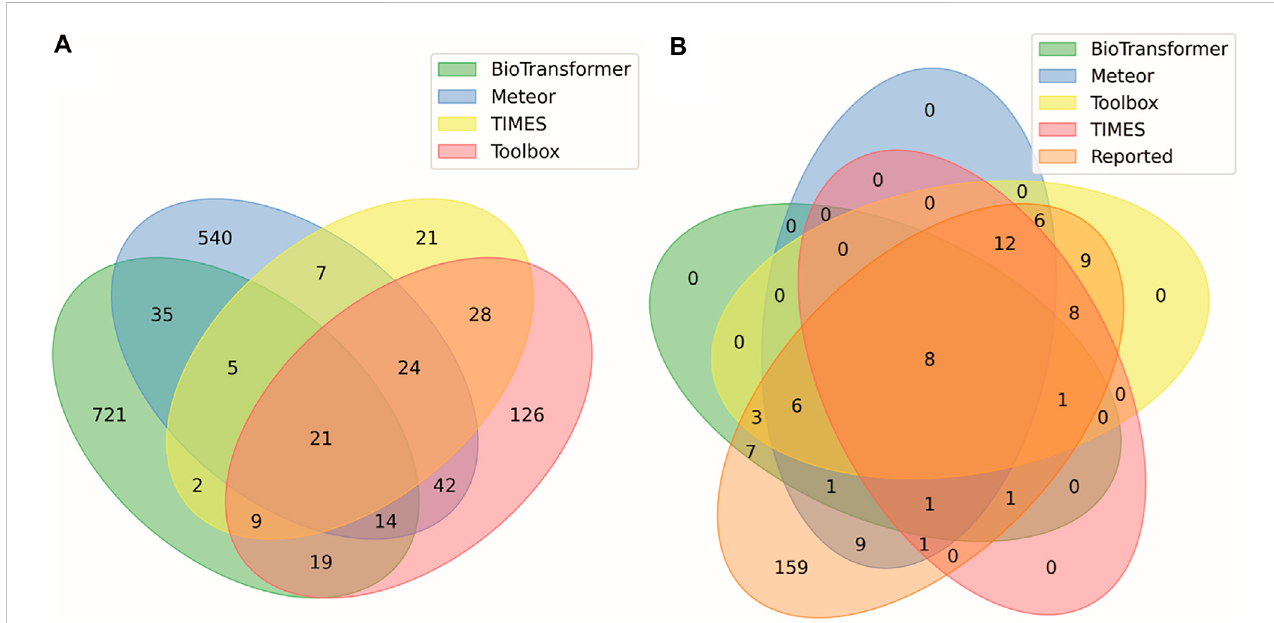
FIGURE 2 Venn diagram displaying concordance between (A) all predicted metabolites and the in silico tools that generated the prediction, and (B) all metabolites reported in literature and in silico tools that generated those predictions. Numbers indicate how many metabolites match the conditions of each ellipse. For example, among the predicted metabolites in (A) there were 28 metabolites predicted by both TIMES (https://oasis-lmc.org) (Mekenyan et al., 2004), and QSARToolbox(https://qsartoolbox.org)(Dimitrovetal.,2016)butnotbytheotherpredictionmethods.Amongthemetabolitesreportedintheliterature in (B) , only 8 of the 28 predicted by only TIMES and ToolBox were previously